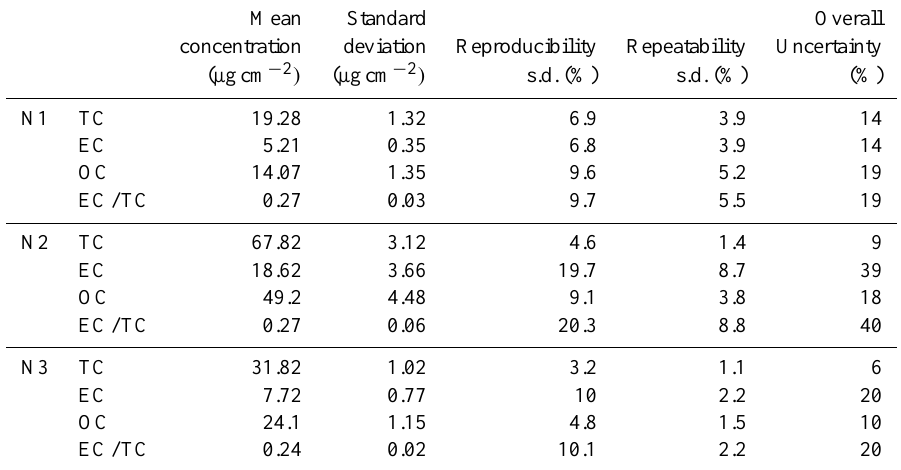
Table 4. Overall laboratory mean concentration (µgcm − 2 ), standard deviation (µgcm − 2 ), reproducibility and repeatability % standard deviations (%) for TC. EC, OC and the EC/TC ratio in samples N1, N2 and